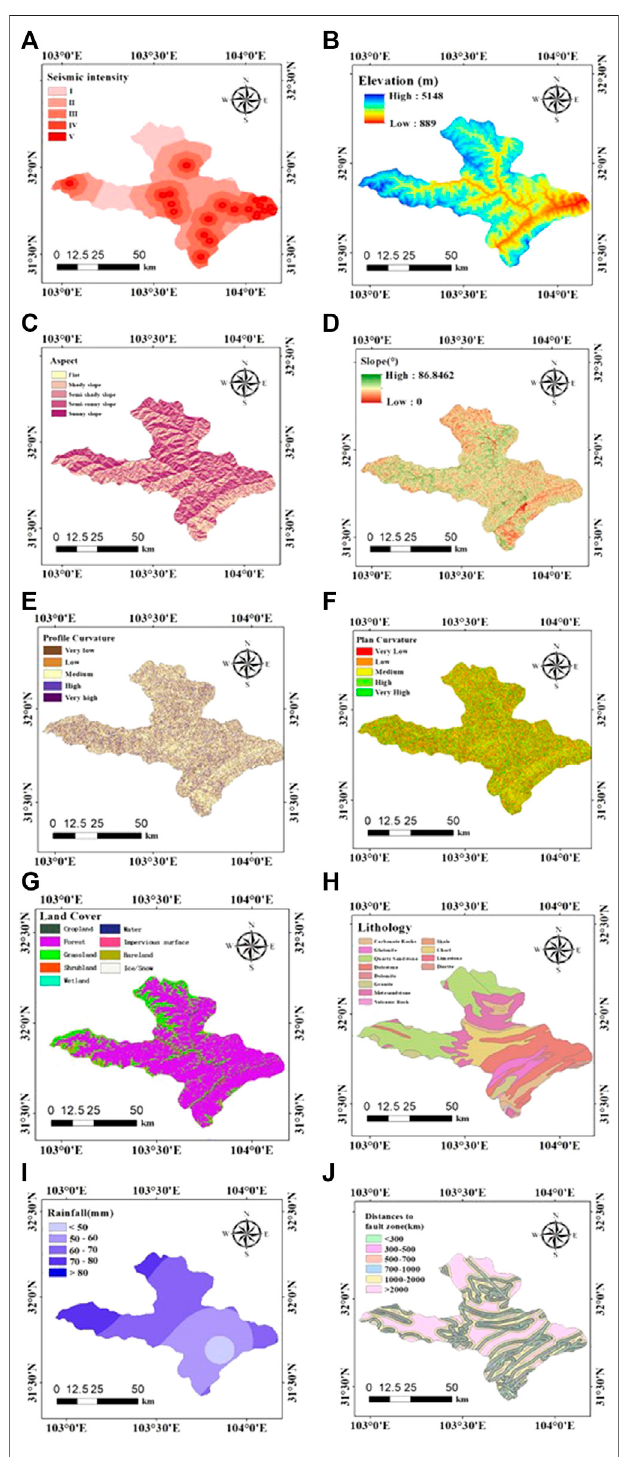
FIGURE 3 | Thematic maps of key factors. (A) Seismic intensity, (B) elevation (C) aspect, (D) slope, (E) pro fi le curvature, (F) plane curvature, (G) land cover, (H) lithology (I) rainfall, and (J) distance to fault zone.